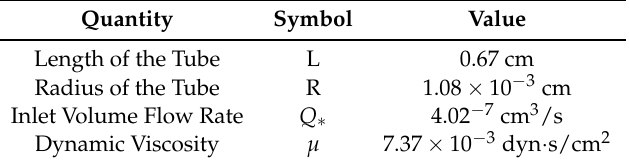
Table 1. Assumed values of dimensions of the tube and some basic flow parameters.